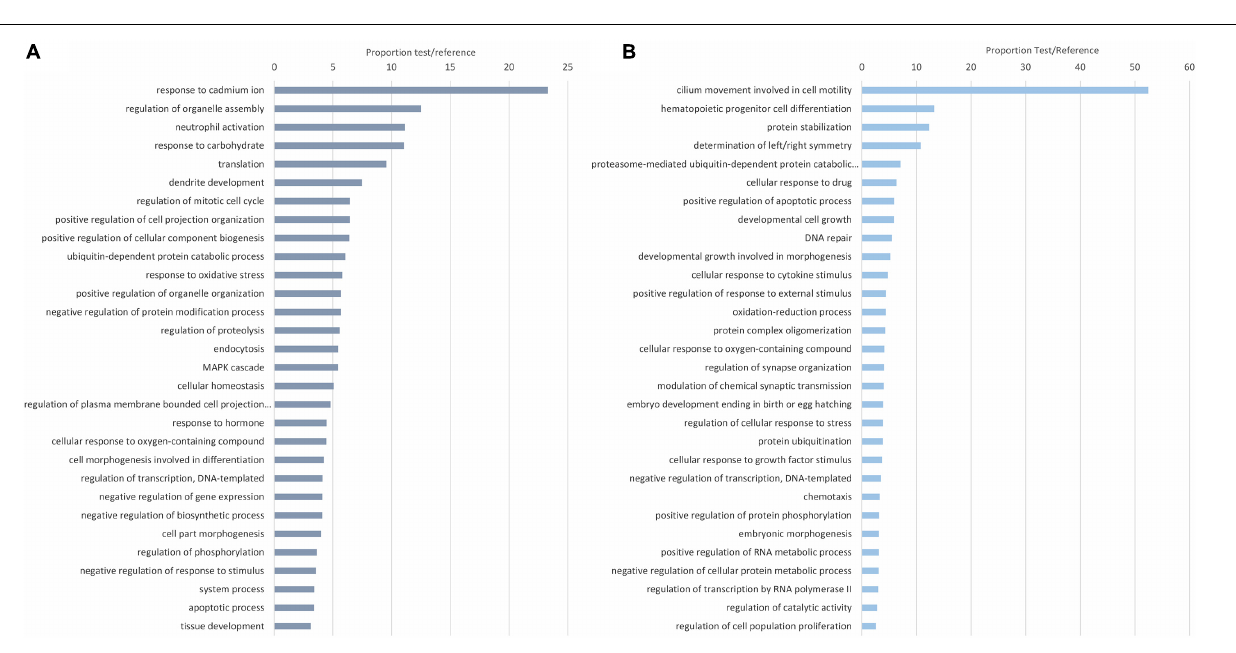
Focusing on specific functions of the modulated proteins, biological processes represented in Figure 4A . Table 2